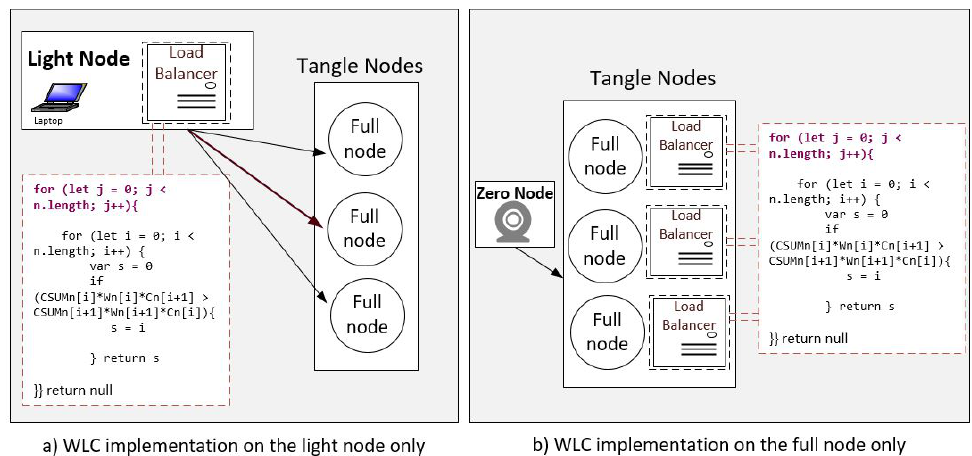
Figure 5. WLC implementation with zero node and light node scenarios. With zero node scenario, the WLC is running on the full node network only. With light node scenario, WLC is running on light node